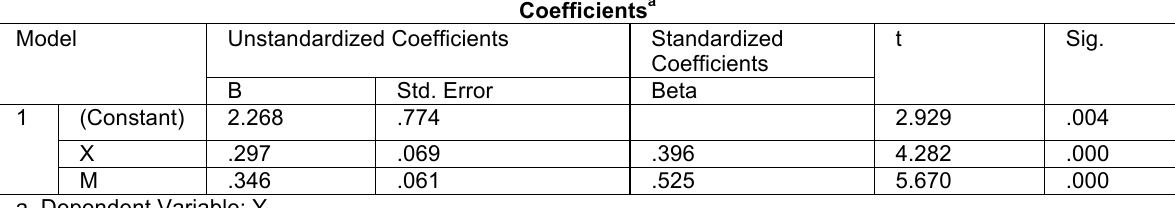
Table 4: Coefficients of Sub-Structure 2 (Model 2)